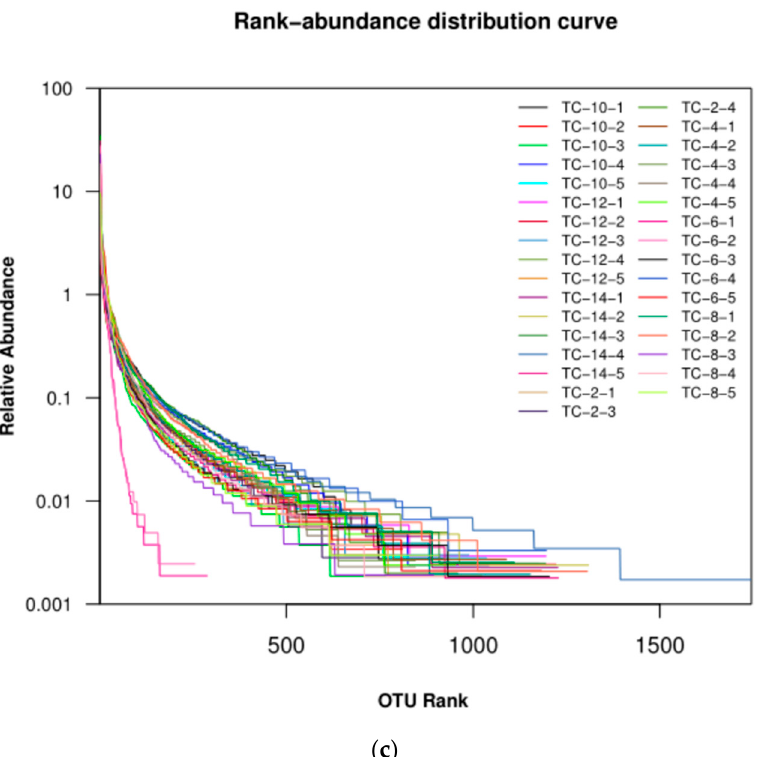
Figure 4. Rank-abundance curves of air ( a ), foreleg ( b ), and thorax ( c ) microorganisms throughout the cooling process.